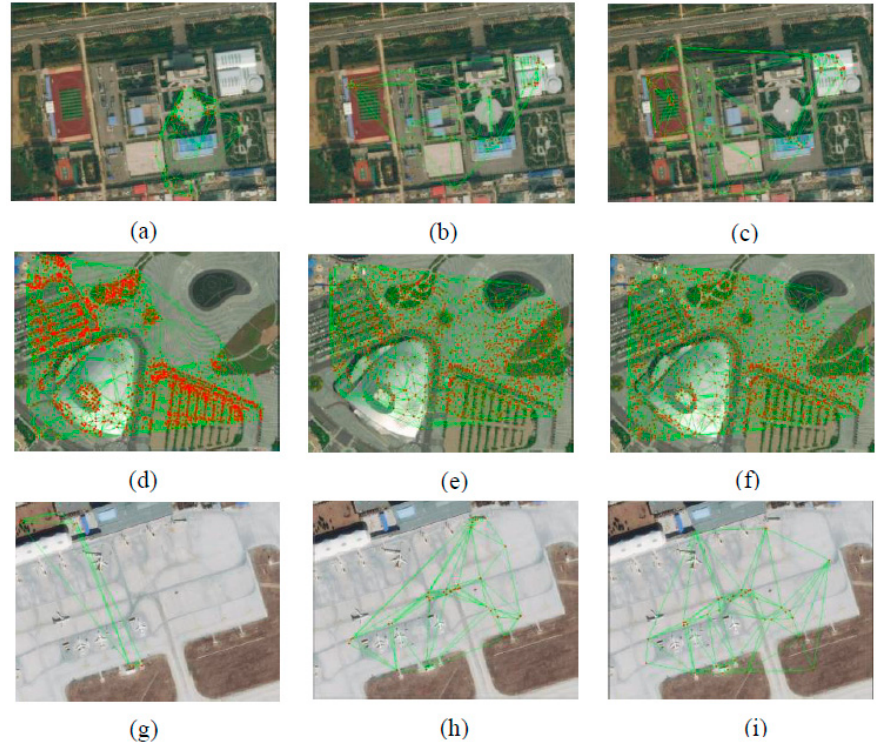
Figure 12. Delaunay triangulation network of matches from aerial stereo images HK1–3. ( a , d , g )